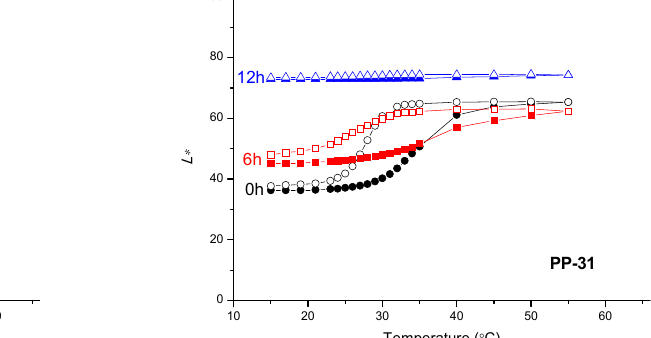
Figure 8. CIELAB lightness L * of TC31 sample in dependence on the temperature at heating (solid signs) and cooling (open signs) on both substrates.